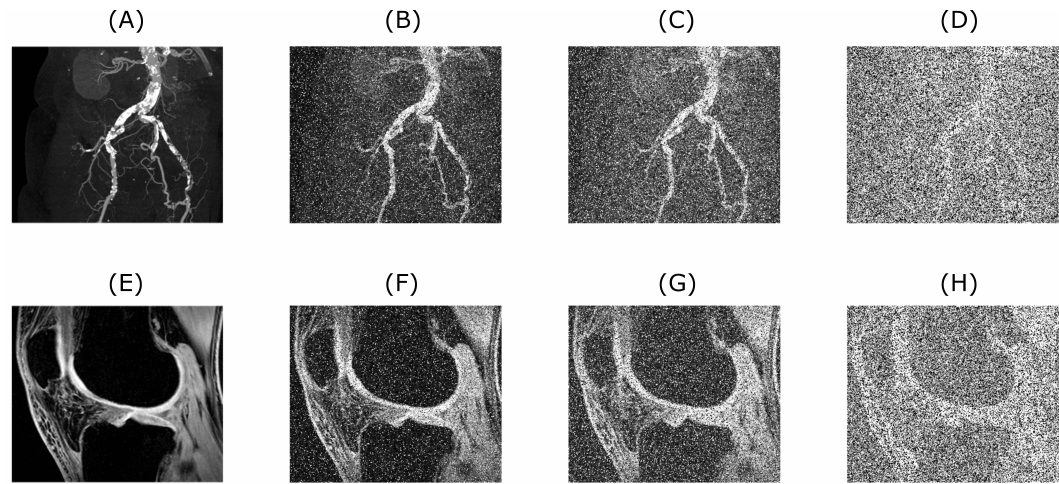
Figure 2. Upper row is showing a CT scan of blood vessel calcification with the native level of noise ( A ) used as an input for algorithm testing. Images ( B – D ) are showing the original image with added artificial noise for 0.1, 0.2 and 0.5 level (in fact the noise consists of a sum of three noise types, in which the number means a mean value for additive white Gaussian noise and density for salt and pepper noise, speckle noise is kept on a constant default value used in MATLAB), respectively. Lower row shows the example of MRI scan of knee cartilage ( E used as an input), again with different consecutive noise levels of corresponding magnitude ( F – H ).